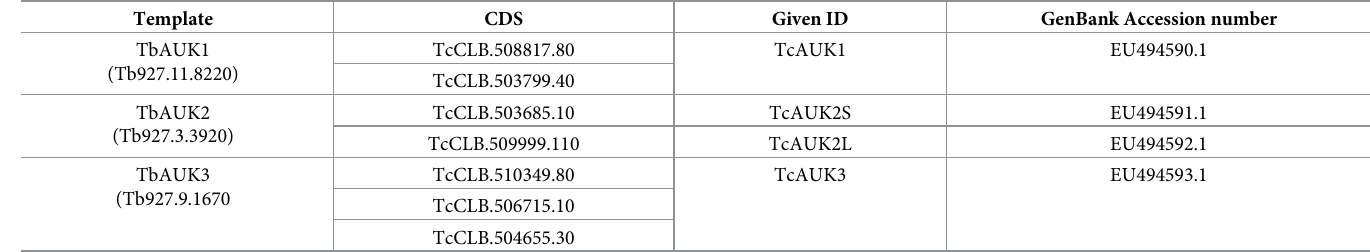
Table 1. Identification of TcAUKs CDS.